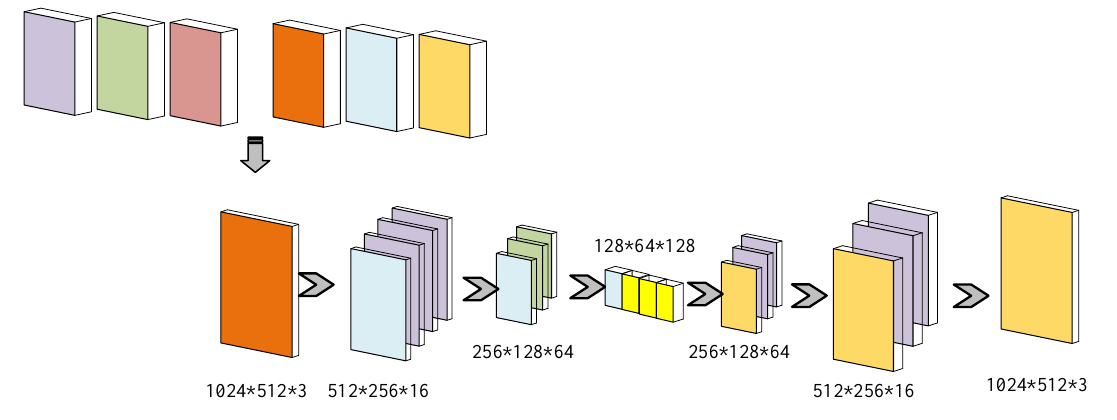
Figure 6. ESNet structure.